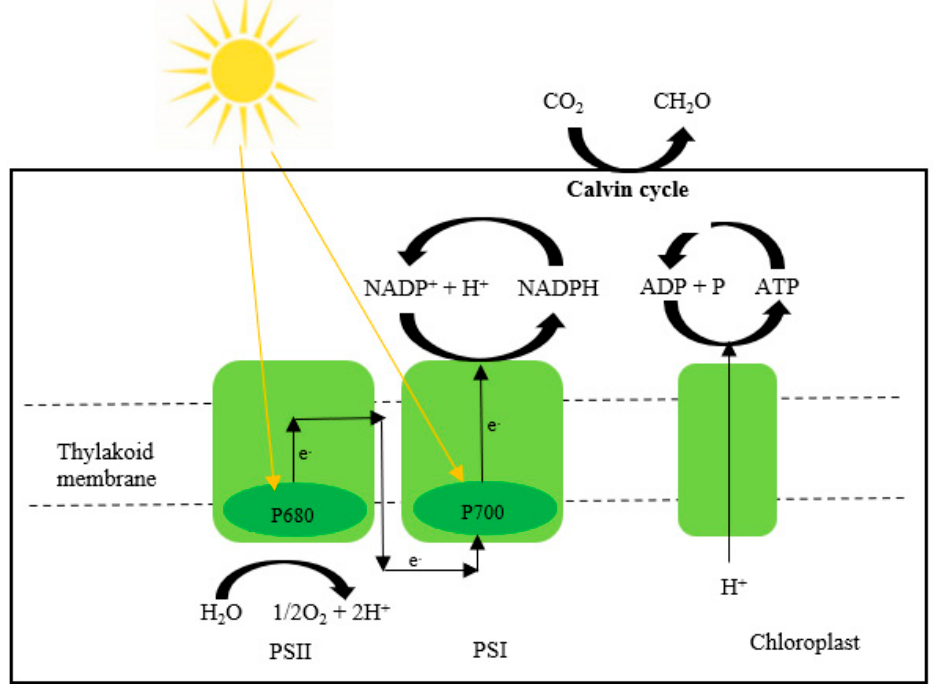
Figure 2. Mechanism of microalgal CO 2 sequestration via photosynthesis [12].